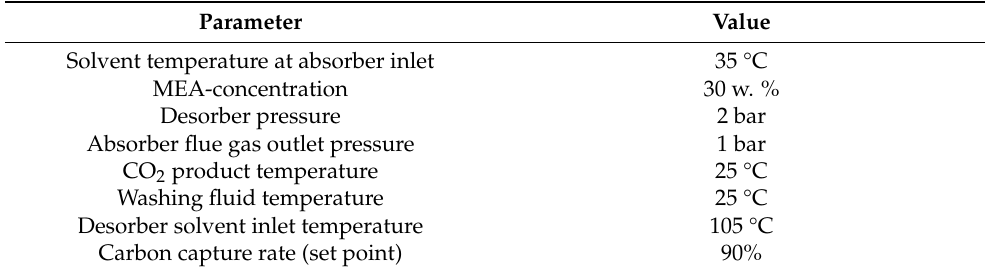
Table 3. Assumed design parameters of amine scrubbing